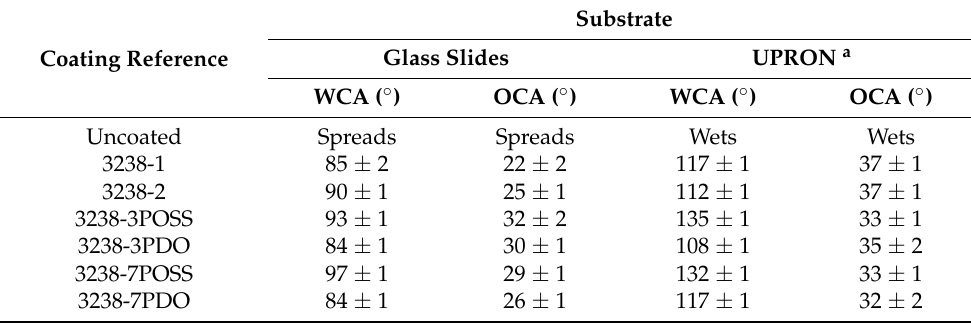
Table 7. WCA and OCA of glass and UPRON substrates coated with